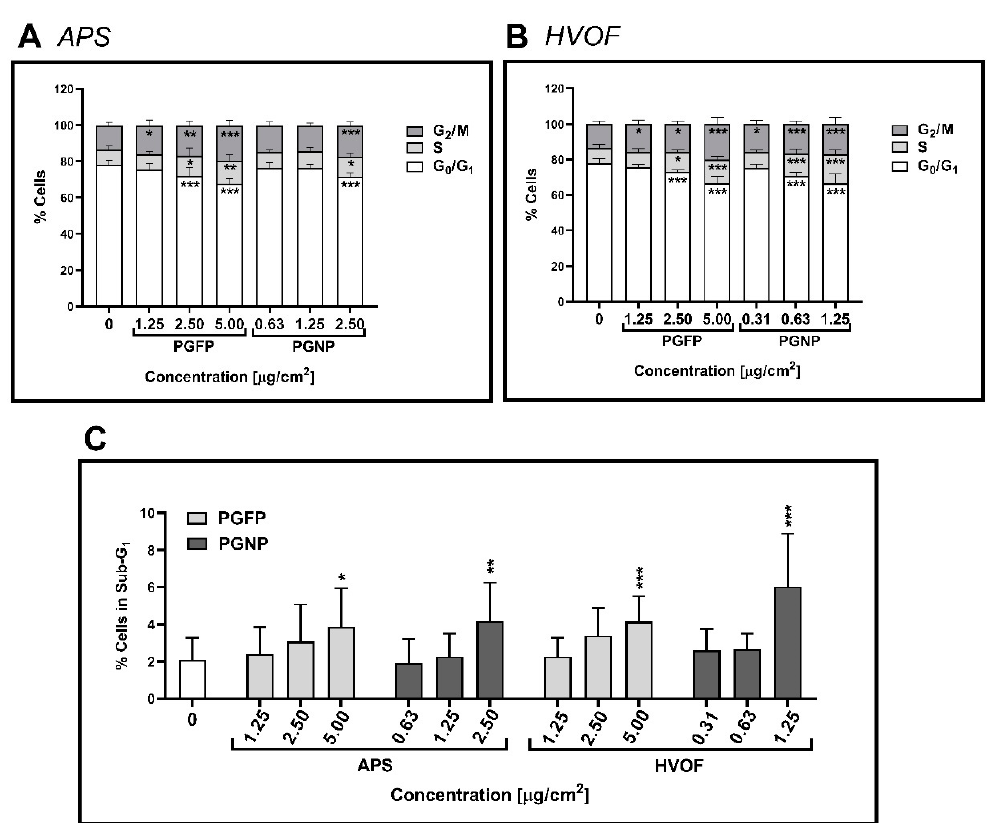
Figure 4. Cell cycle analysis of human alveolar epithelial cells after 24 h of exposure to PGFP and PGNP released during APS ( A ) and HVOF ( B ). The percentage of cells in the sub-G 1 phase (apoptotic cells) was also analysed ( C ). Data are expressed as means ± standard deviations (n = 3–4). Data were analysed by one-way ANOVA followed by Dunnett’s post-hoc test. * p ≤ 0.05, ** p ≤ 0.01 and *** p ≤ 0.001 vs. NC.